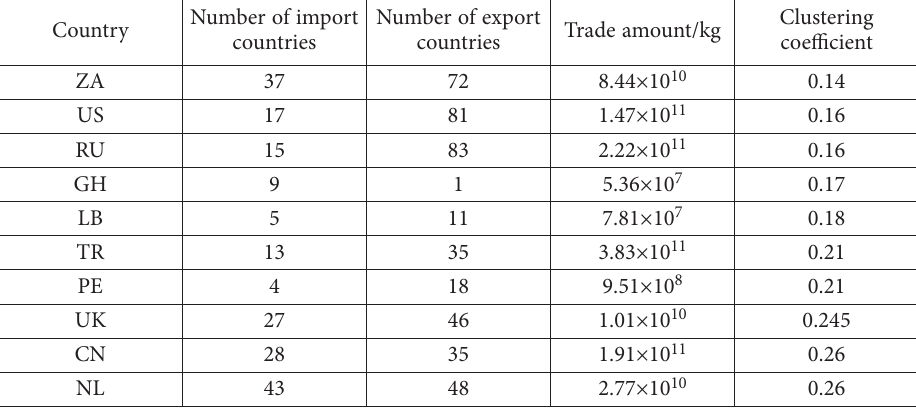
Table 3. Ten countries with lower clustering degree in 2018 Number of import Country